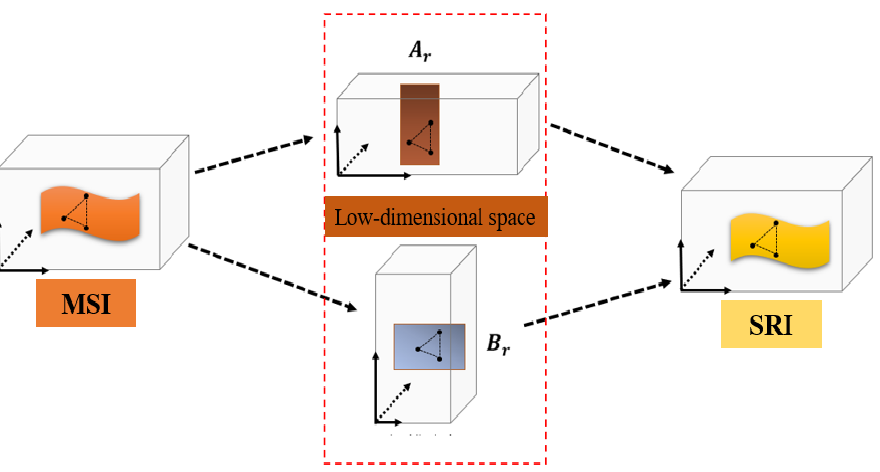
Figure 2. The manifold structure preservation between MSI and HR-MSI.